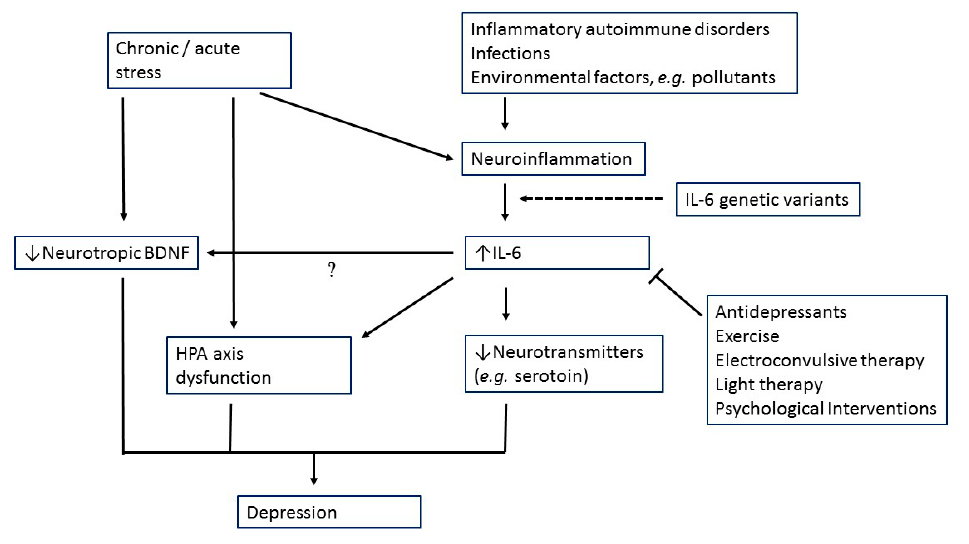
Figure 1. Possible role of interleukin-6 (IL-6) in major depression pathogenesis.